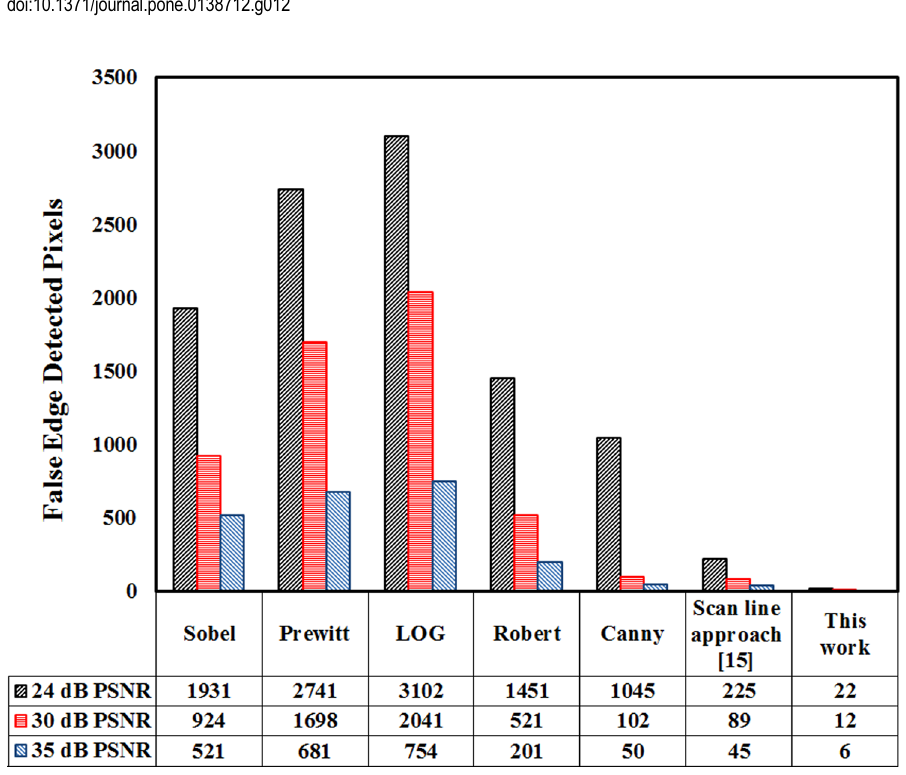
Fig 13. False edge detection in a smooth clinical image of 270 x 290 pixels with 24 dB noise level.